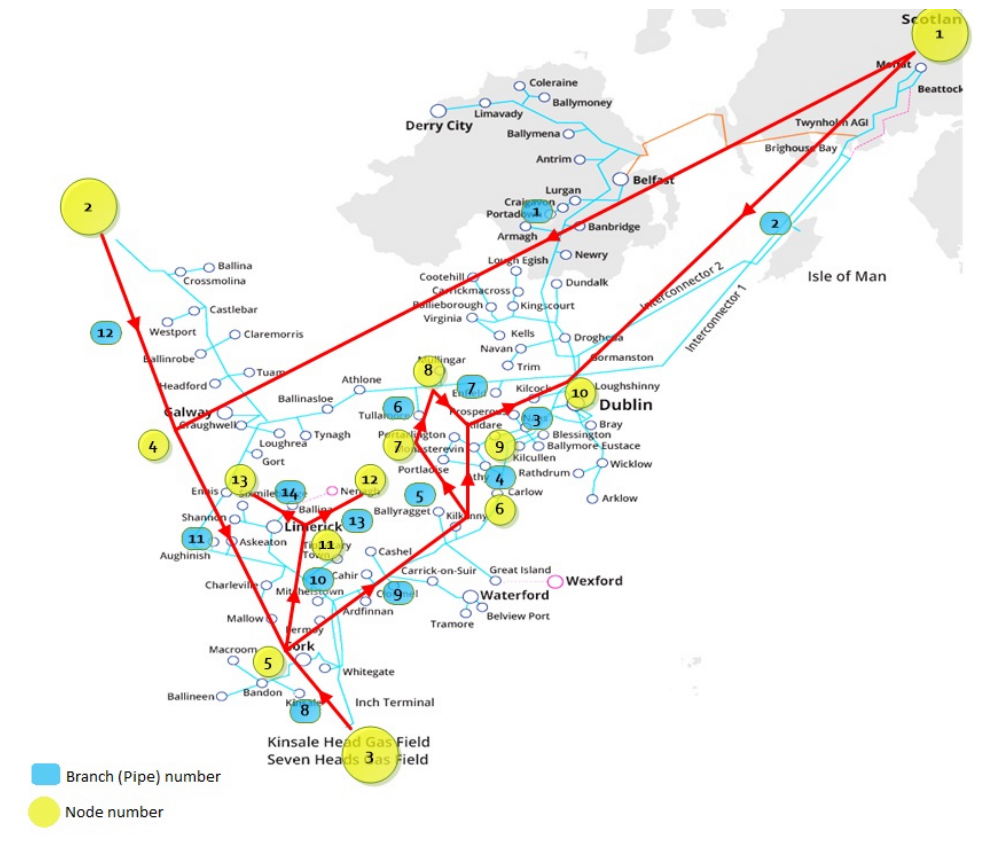
Figure 2. A simplified gas network of Ireland with 13 nodes and 14